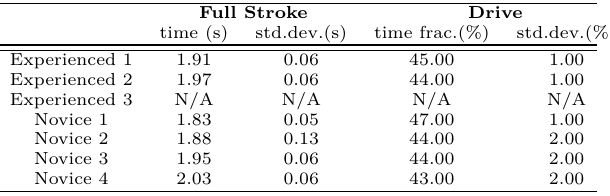
Table 3: Stroke timing consistency for 30 strokes